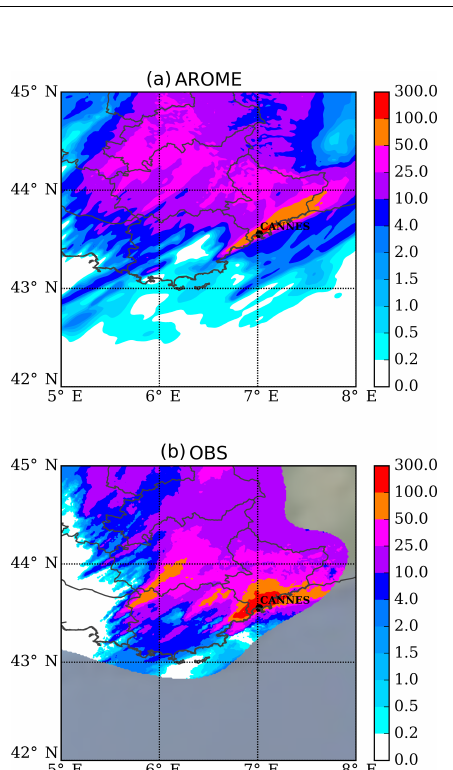
Figure 3. Maps of 3h cumulated precipitations (mm) between 18:00 and 21:00UTC over the southeast of France, for the case of 3 October 2015. (a) AROME-France forecast starting at 03:00UTC, (b) Antilope 3h precipitation analysis taken as proxy to the obser- vation (Laurantin,